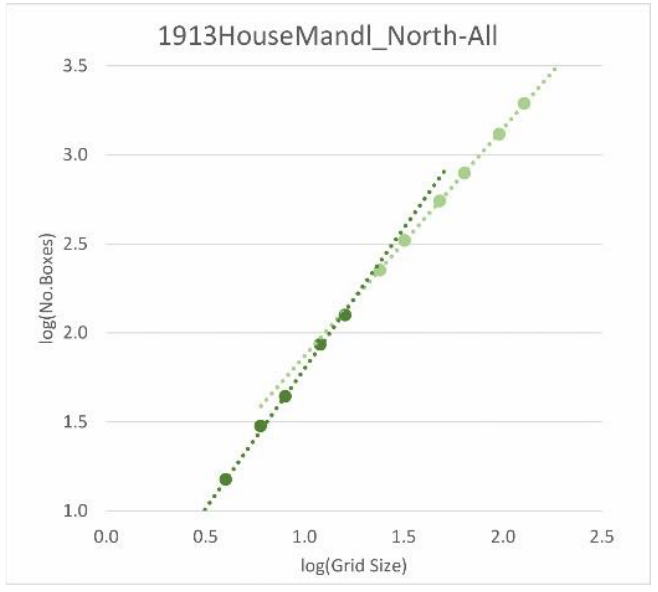
Figure 13. Kink in the data curve between the range of larger and smaller box sizes for House Mandl.